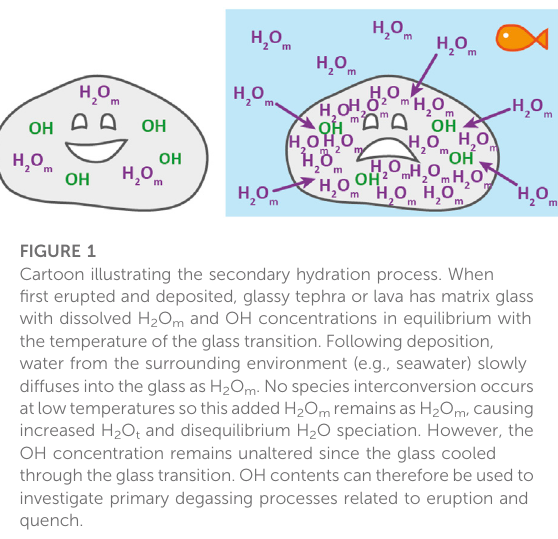
Figure 1). Accurate measurement of OH content by FTIR combined with the H 2 O speciation relationships constrained